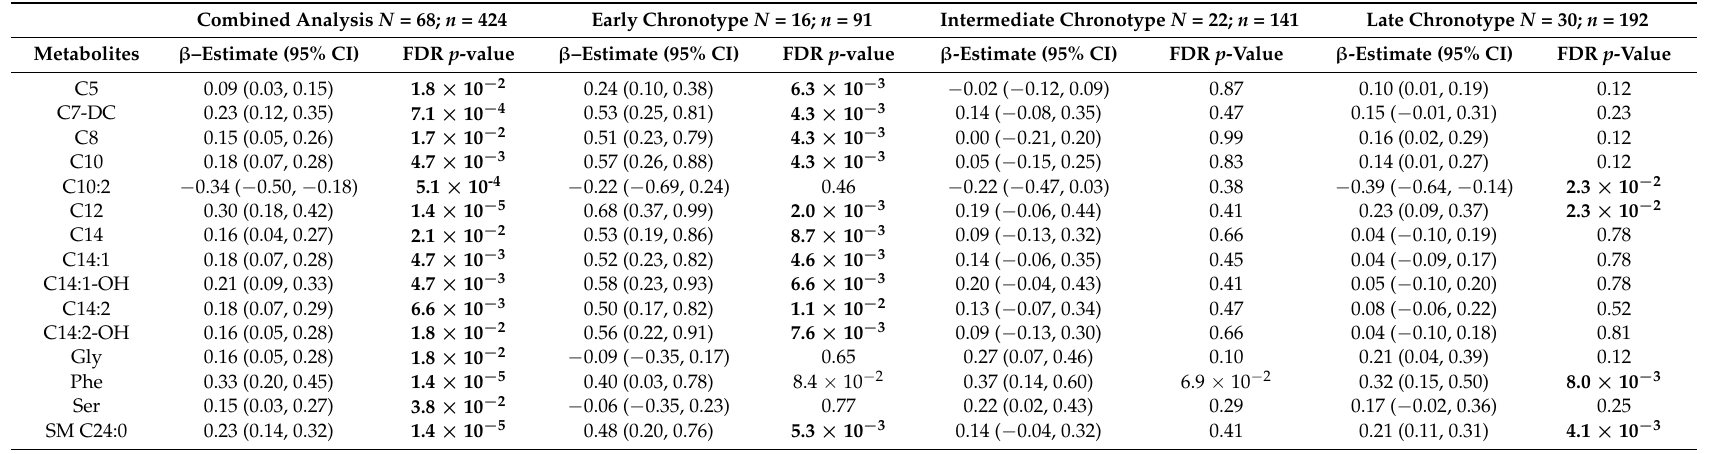
Table 3. Results of 15 metabolites significantly altered by night shift work in combined and chronotype-stratified analysis based on creatinine-normalized values in the fully adjusted model. For each metabolite, the β -estimate, the 95% confidence interval (CI) and false discovery rate (FDR) of the full linear mixed effect model (LMEM) for the comparison of day shift (reference) and night shift are shown. The full linear model was adjusted for chronotype, batch effect, smoking status, age, BMI, thyroid disease status, total years of shift work, day of shift and time since last urination. Significant p -values (FDR < 0.05) in both basic and full LMEM model are indicated in bold. N = Number of nurses; n = Number of urine